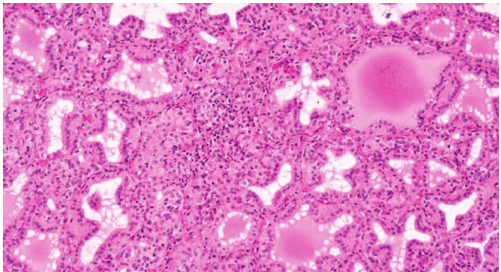
Figure 7: Thyroid sections folded, empty, and vacuolated content follicular structures and a disrupted follicular zone, with pyknotic nucleus in ewes, H&E 160x.